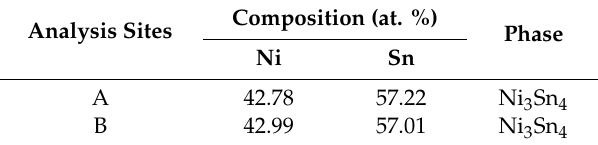
Table 3. EDS compositional analysis of IMC phases formed in Ni / Sn / Ni micro-joints. Analysis